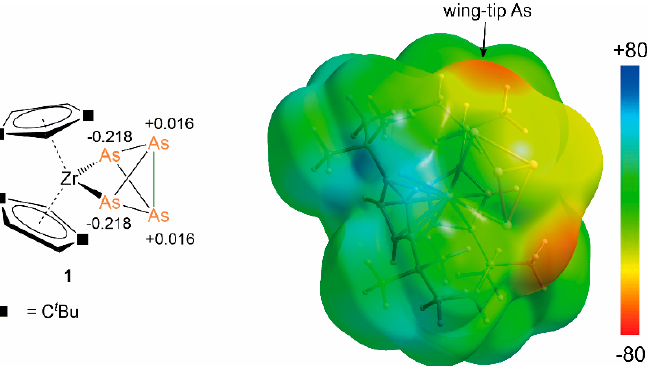
Figure 2. Natural charge distribution (left) of 1 and electrostatic potential mapped on electron density (right). Iso-value 0.001. Color ranges in kJ·mol − 1 .